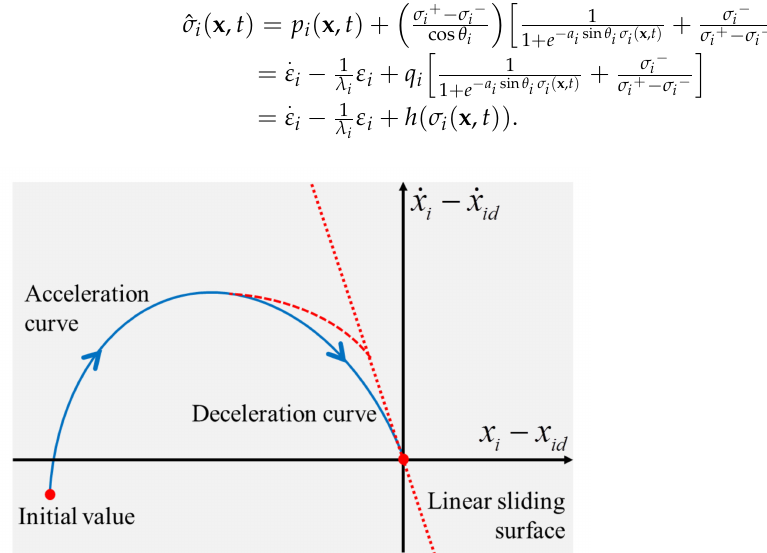
Figure 3. State trajectory with a linear sliding surface.